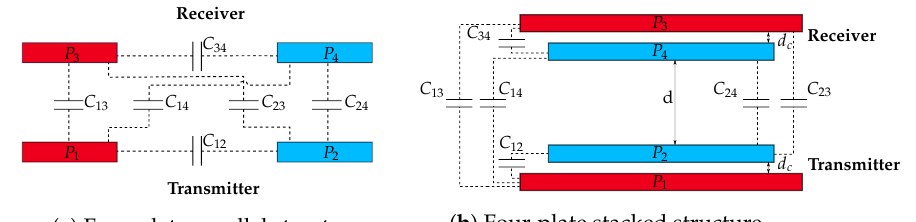
Figure 9. Four-plate CPT